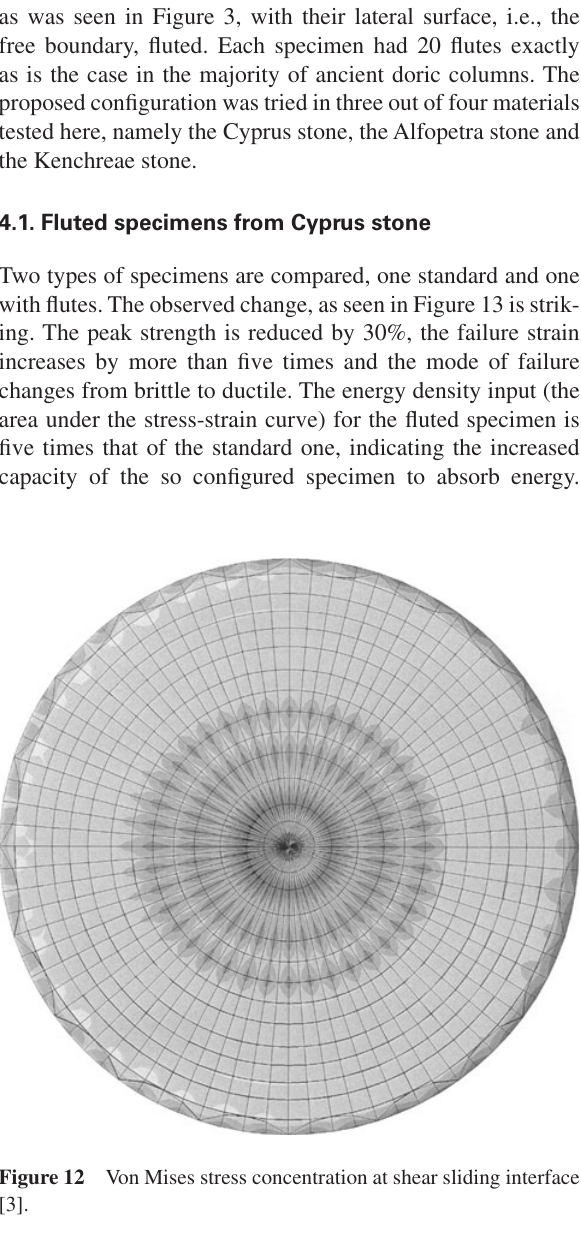
Figure 13 Comparison between standard and fl uted specimens from Cyprus